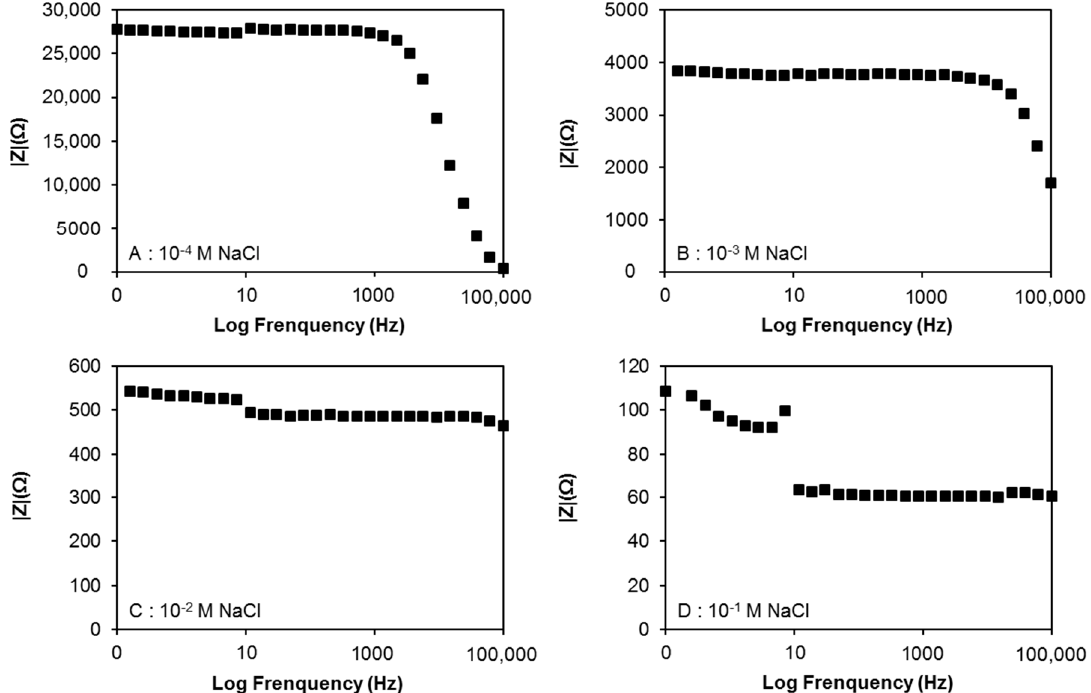
Figure 12. Variation of the impedance values as a function of alternating current frequency resulting from measurements carried out on the second electrode couple (I-F5F2_E-F4F3_AgCl) in sodium chloride solutions of different concentrations: ( A ) 10 − 4 M, ( B ) 10 − 3 M, ( C ) 10 − 2 M, ( D ) 10 − 1 M.